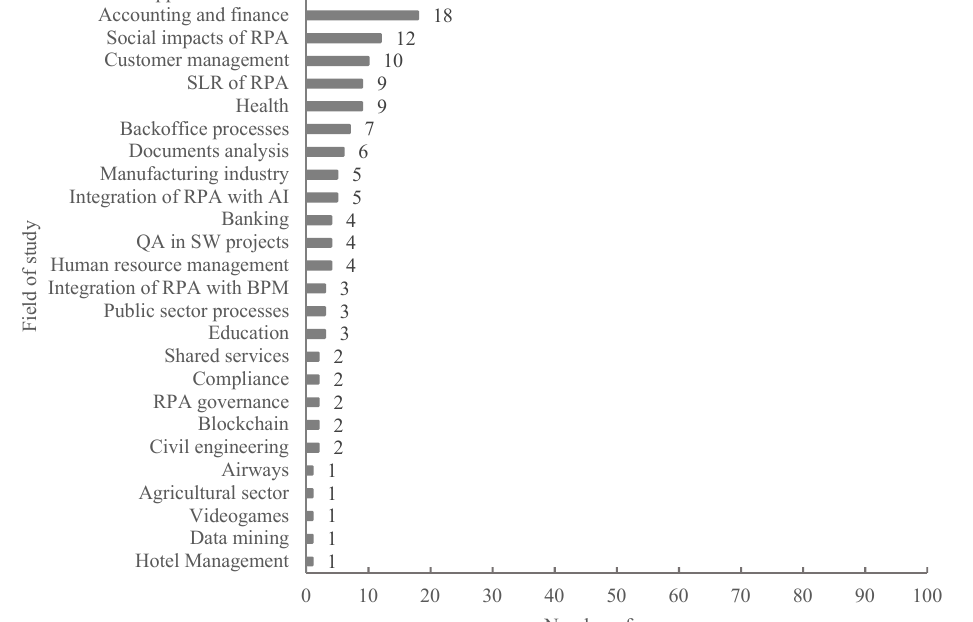
Figure 4. Field of study of the selected papers.